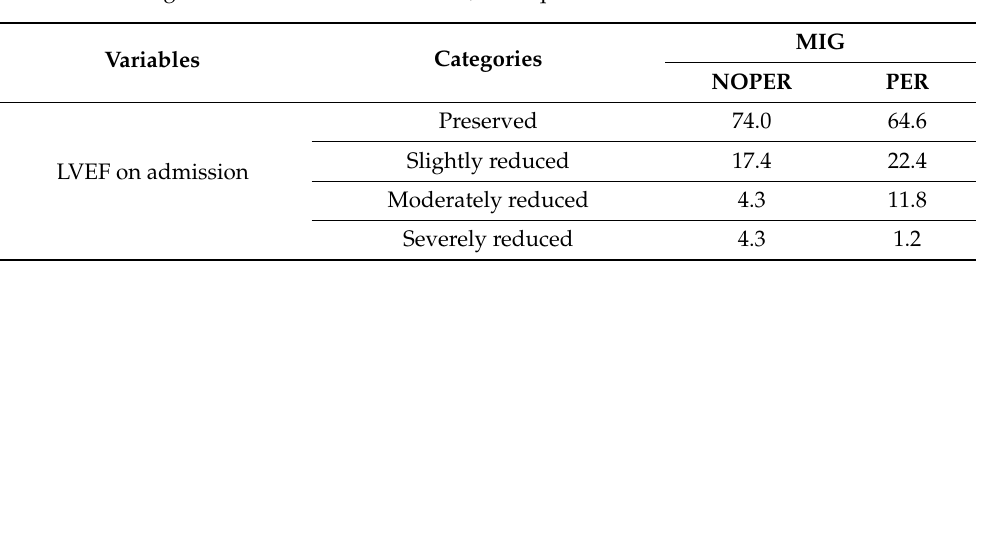
Table 6. Percentages of cardiac variables in MIG; Chi-square